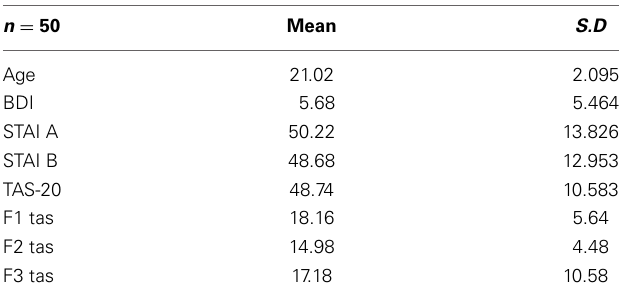
Table 1 | Means and standard deviations (in parentheses) for the whole sample ( n = 50) for age, BDI and STAI and TAS-20 psychological tests.